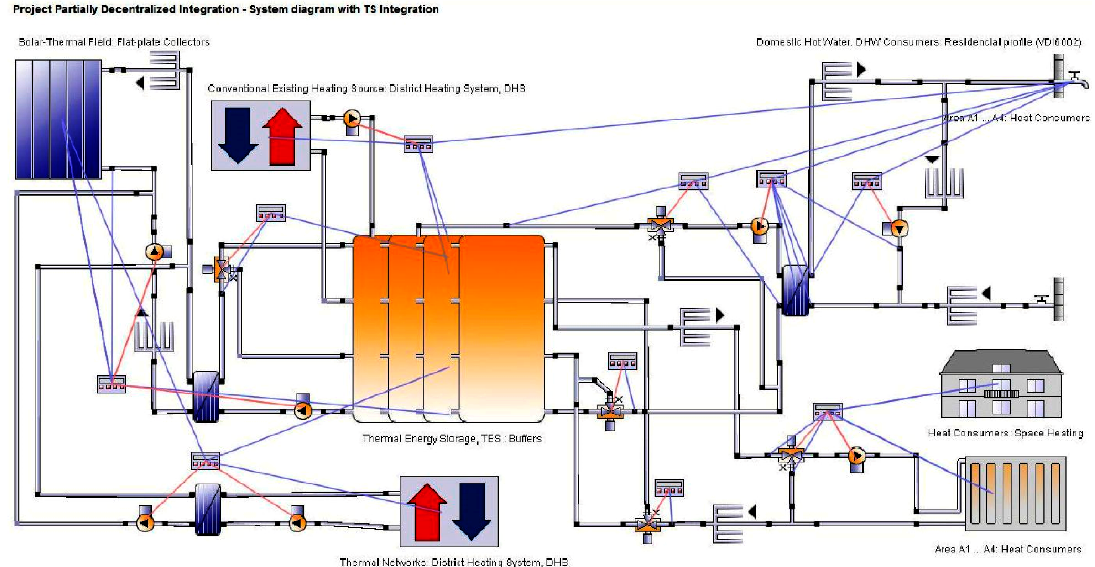
Figure 5. Optimized hybrid heating system with the integration of area thermal stations (TS). Hydraulic scheme of the principle [51].